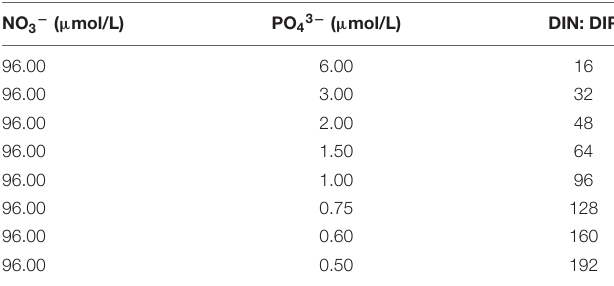
TABLE 1 | Initial nutrient concentrations in the different size-fractionated phytoplankton cultures used for the